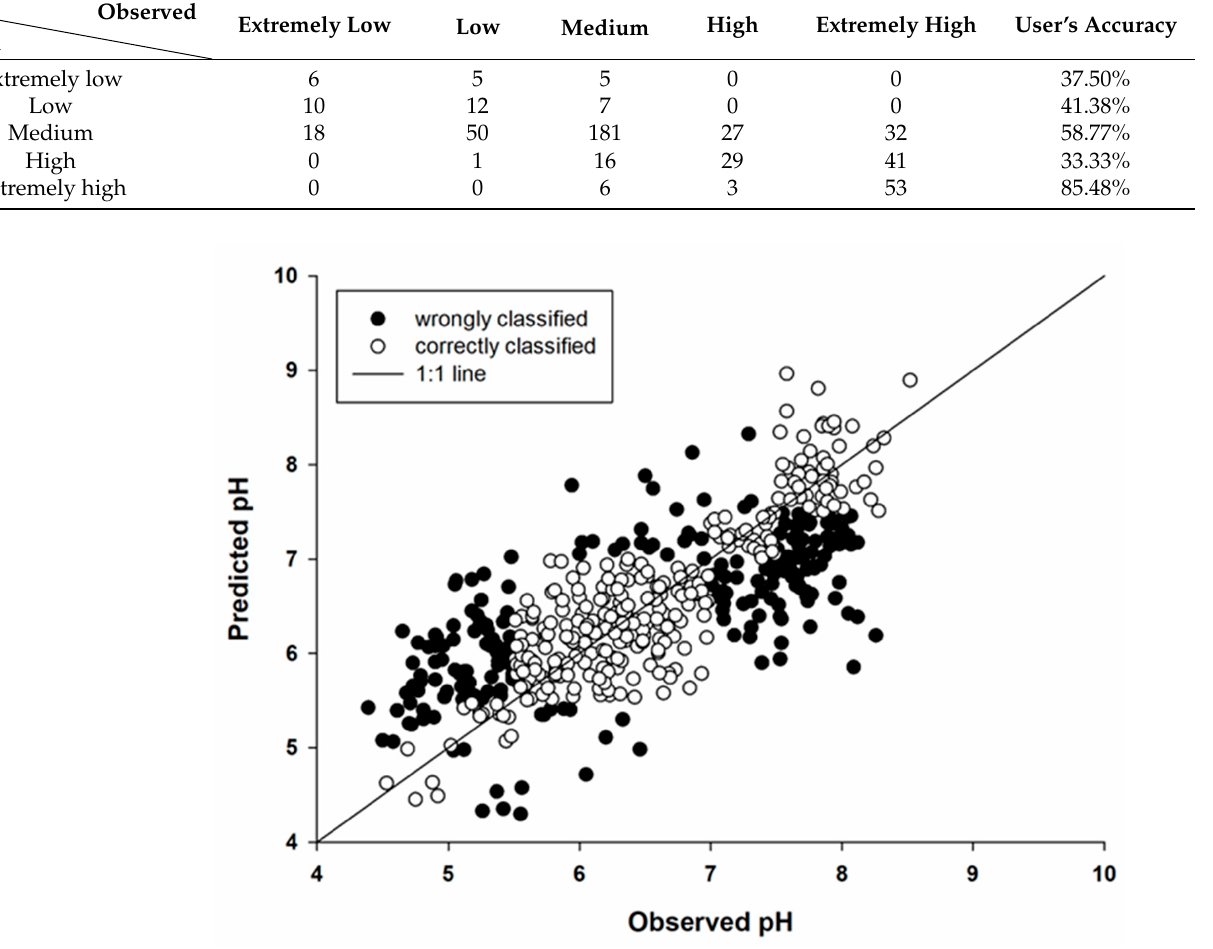
Table 8. Allocation confusion matrix of pH.